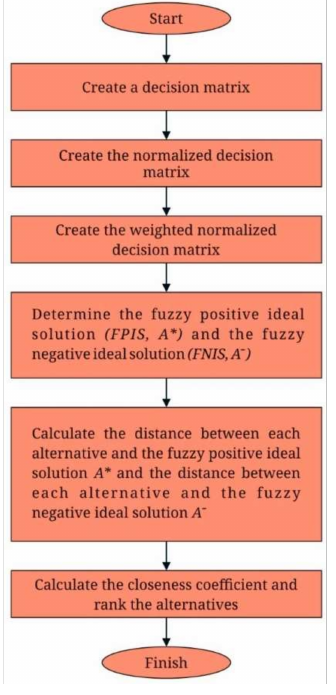
Figure 2. Flow diagram of fuzzy TOPSIS method. Table 2. Characteristics of different criteria.